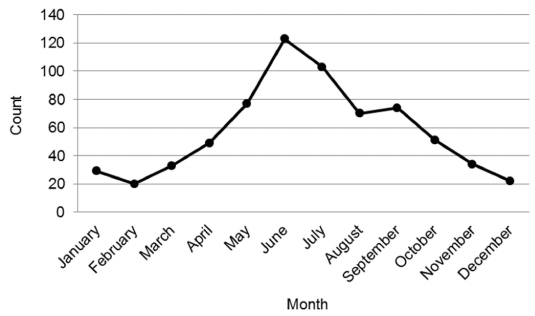
Figure 1. Distribution of events in childhood reported by month,